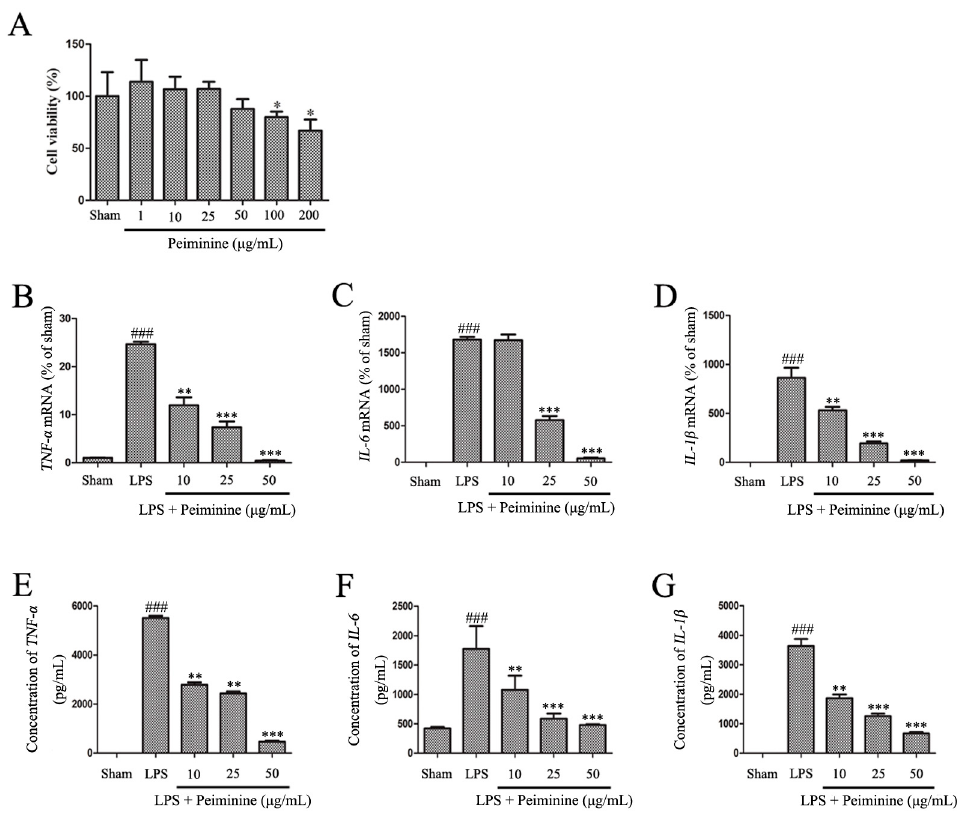
Figure 4. Peiminine inhibits the LPS-induced inflammatory response in BV-2 cells. ( A ) The effects of peiminine (1, 10, 25, 50, 100 and 200 μ g/mL) on the viability of BV-2 cells. BV-2 cells were pretreated with various concentrations of peiminine (10, 25 or 50 μ g/mL) for 1 h, then stimulated with LPS for 4 h. The expression of the TNF- α ( B ), IL-6 ( C ) and IL-1 β ( D ) mRNA was determined using quantitative real-time PCR ( n = 3). Cells were pretreated with various concentrations of peiminine (10, 25 or 50 μ g/mL) for 1 h, stimulated with LPS for 12 h, and the levels of the TNF- α ( E ), IL-6 ( F ) and IL-1 β ( G ) proteins in media supernatants were measured using ELISA ( n = 3). ### p < 0.001 compared to the sham group, * p < 0.05 compared to the sham group, ** p < 0.01 and *** p < 0.001 compared to the sham group.